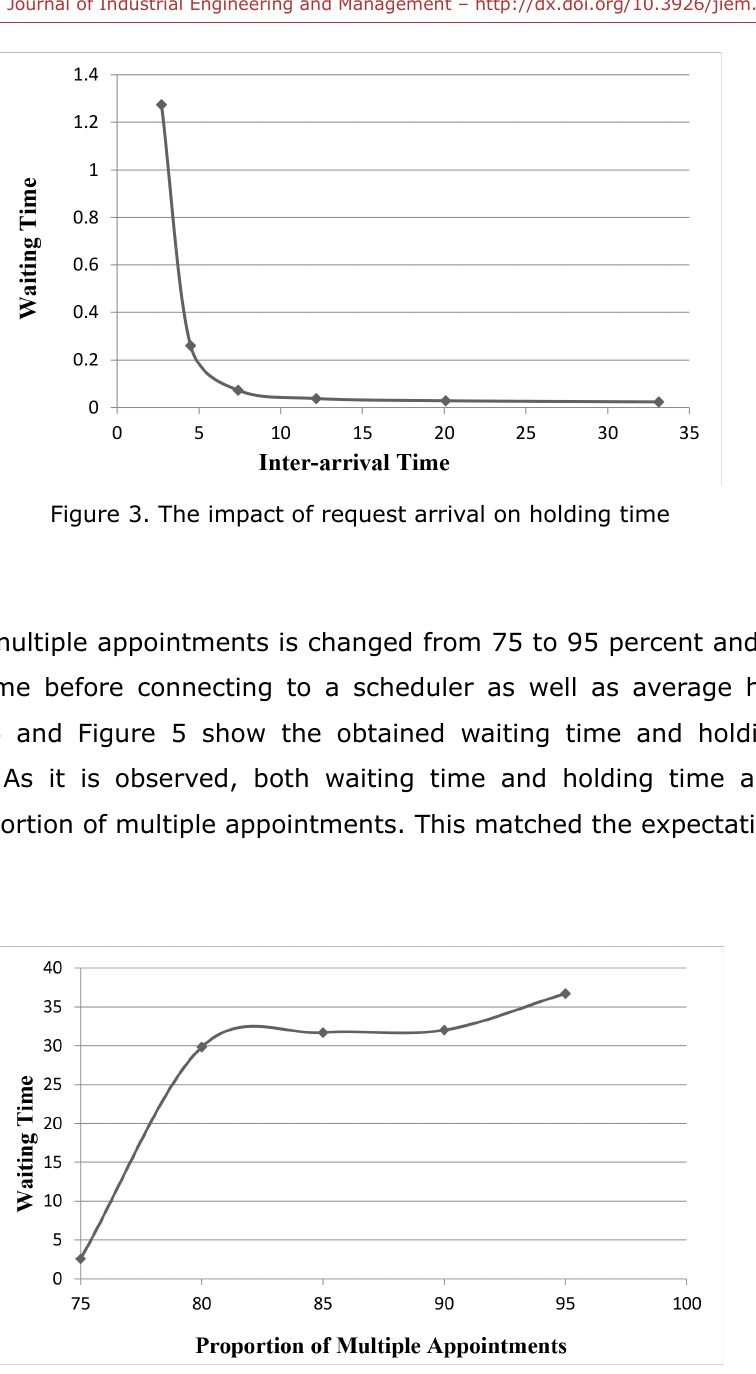
Figure 4. Impact of proportion of multiple appointments on waiting